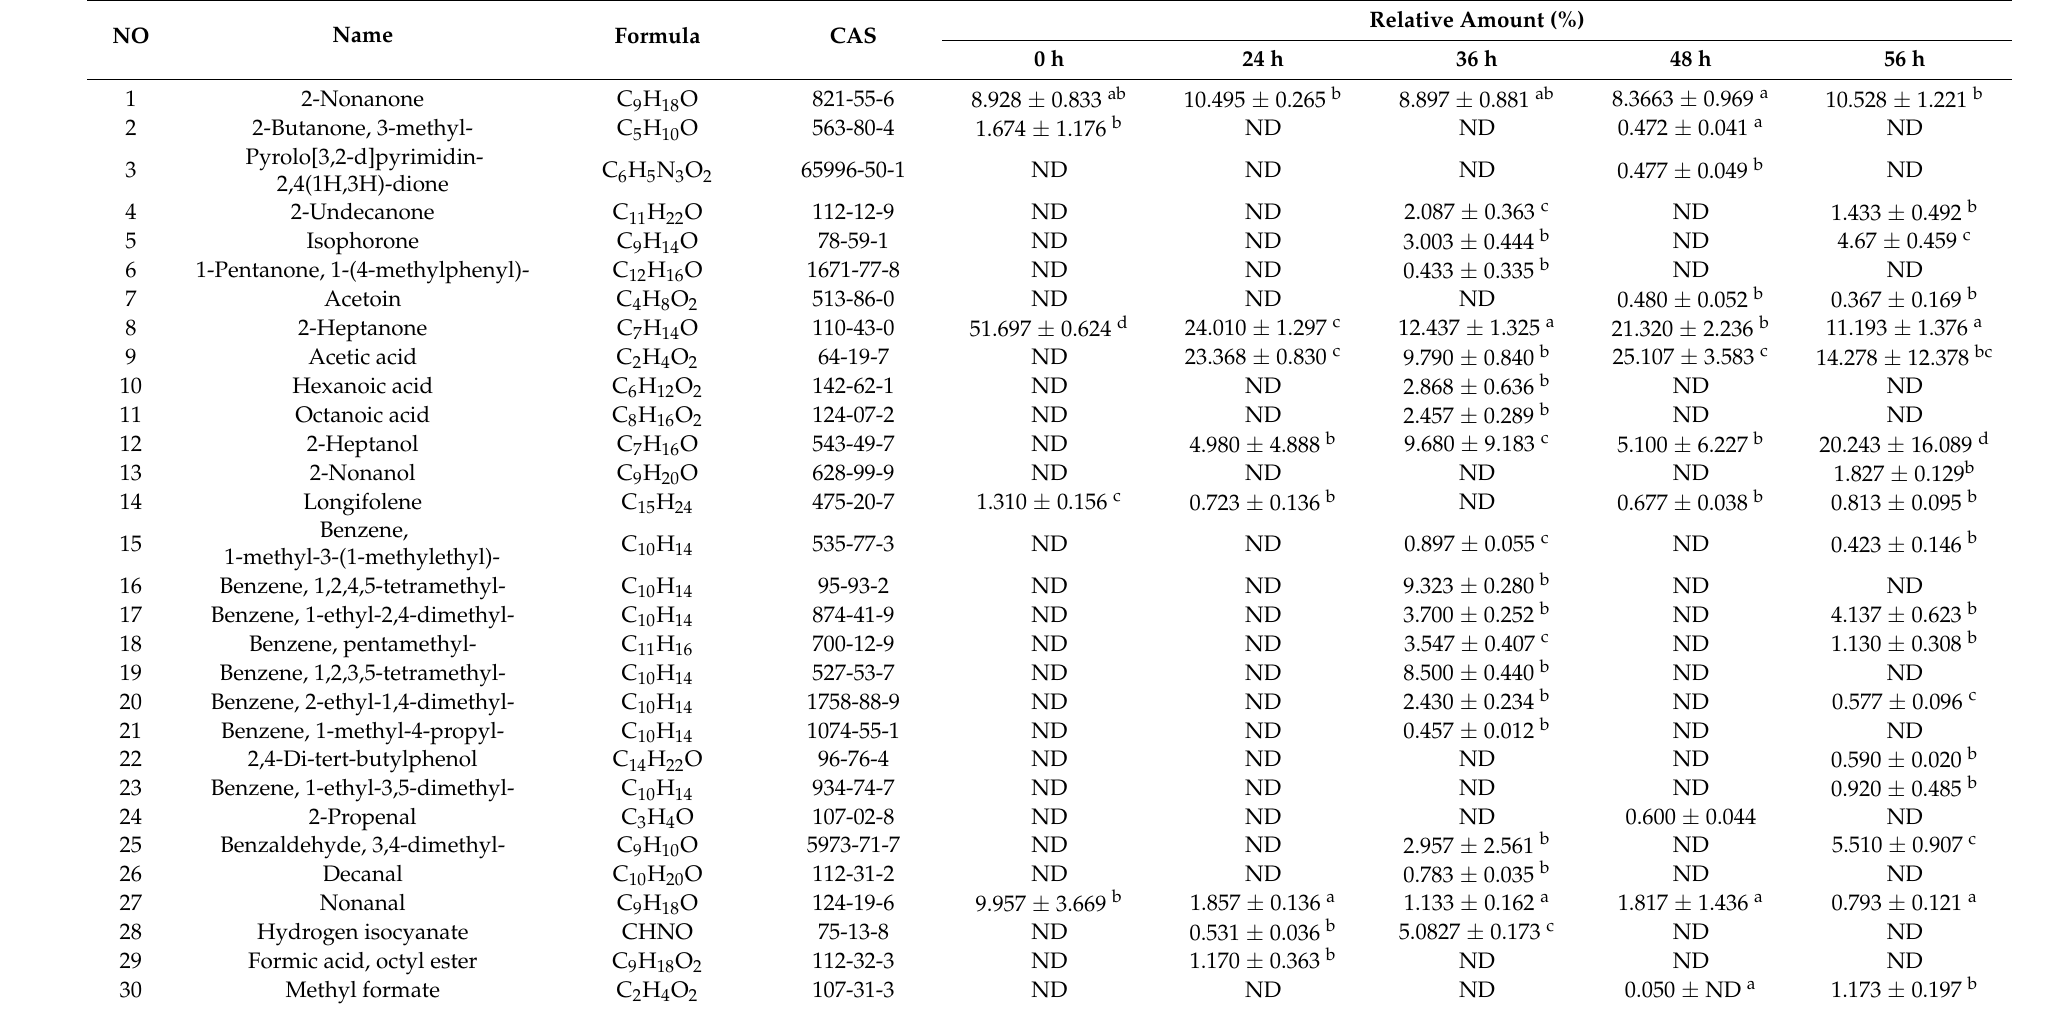
Table 9. Five fermentation stages of fermented milk were detected by